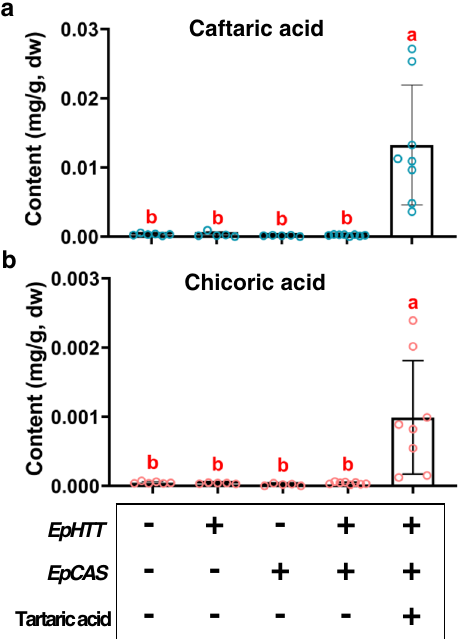
Fig. 6 Reconstruction of chicoric acid biosynthesis in Nicotiana benthamiana leaves. a Caftaric acid and b chicoric acid contents of N. benthamiana leaves in fi ltrated with different combinations of genes and precursor. Data are mean±s.d. ( n = 8, 5, 5, 6, 8 biologically independent samples, respectively). Lowercase letters indicate signi fi cant differences from each other ( P < 0.05) analyzed by one-way ANOVA with Tukey ’ s multiple comparisons test. Source data are provided as a Source Data fi le.